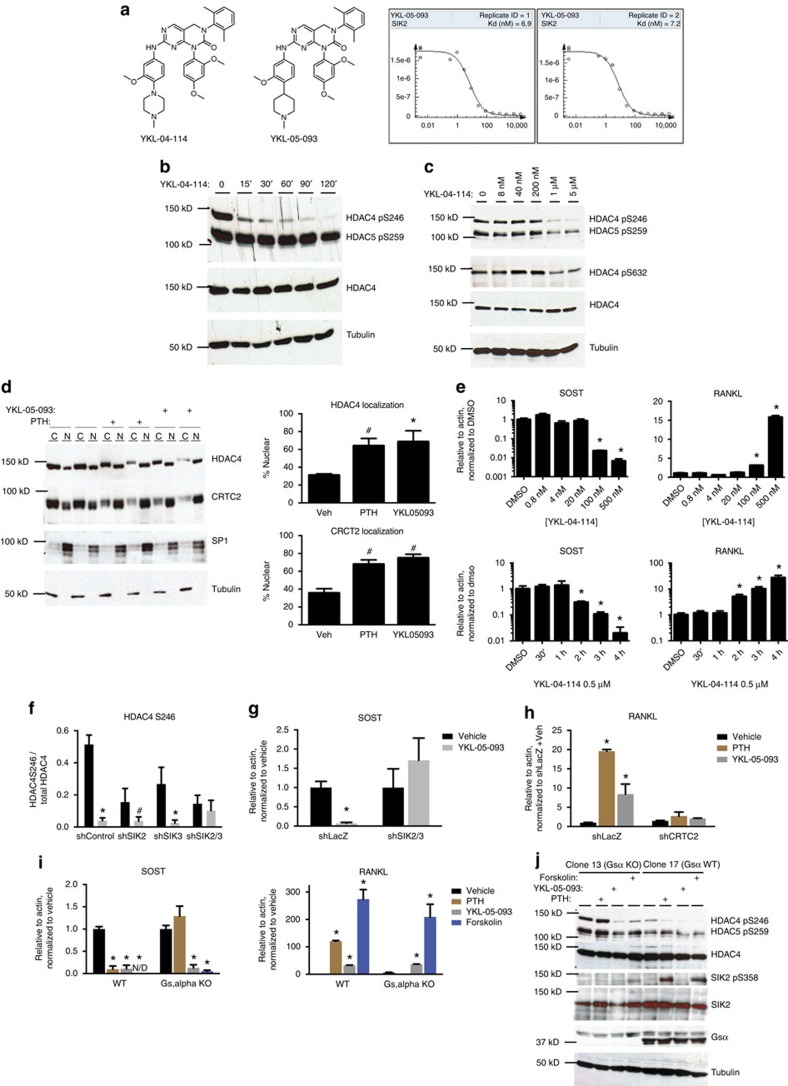
SIK inhibitors regulate SOST and RANKL expression.(a) Structure of YKL-04-114 (left), YKL-05-093 (middle) and YKL-05-093 Kd determination curves for SIK2 (right). For the Kd determination curves, the y-axis represents the amount of bound kinase measured by qPCR (see Methods), and the x-axis represents the corresponding compound concentration in nM. (b) Ocy454 cells were treated with YKL-04-114 (10 μM) for the indicated times, followed by immunoblotting of whole cell lysates as indicated. (c) Ocy454 cells were treated with the indicated concentrations of YKL-04-114 for 60 min, followed by immunoblotting of whole cell lysates as indicated. (d) Left: Ocy454 cells were treated with vehicle, PTH (50 nM) or YKL-05-093 (10 μM) for 60 min. Cytosol and nuclear fractions were then generated, followed by immunoblotting as indicated. Right: quantification of nuclear fraction (defined as nuclear/total) of HDAC4 or CRTC2. * indicates P<0.01 comparing treatment versus vehicle. (e) Top: Ocy454 cells were treated with the indicated concentrations of YKL-04-114 for 4 h, followed by RT-qPCR. Bottom: Cells were treated with YKL-04-114 (0.5 μM) for the indicated times. * indicates P<0.05 comparing treatment versus vehicle. (f) Cells lacking SIK2, SIK3 or both were treated with YKL-05-093 (10 μM for 45 min). Quantification of HDAC4 S246 phosphorylation, as assessed by densitometric analysis of immunoblots, is shown. * indicates P<0.01 comparing treatment versus vehicle. # indicates P<0.05 for the same comparison. (g) Control and SIK2/3 deficient cells were treated with YKL-05-093 (0.5 μM) for 4 h and SOST transcript abundance was measured by RT-qPCR. (h) Control and CRTC2 shRNA cells were treated with PTH (1 nM) or YKL-05-093 (0.5 μM) for 4 h and RANKL transcript abundance was measured by RT-qPCR. (i) Control and Gsα-deficient Ocy454 cells were treated with PTH (1 nM), YKL-05-093 (0.5 μM) or forskolin (5 μg ml−1) and SOST and RANKL transcript abundance was determined by RT-qPCR. For (h) and (i), * indicates P<0.05 comparing treatment and vehicle. (j) Control and Gsα-deficient Ocy454 cells were treated with PTH (50 nM), YKL-05-093 (10 μM) or forskolin (5 μg ml−1) for 30 min. Whole cell lysates were generated and immunoblotted as indicated.